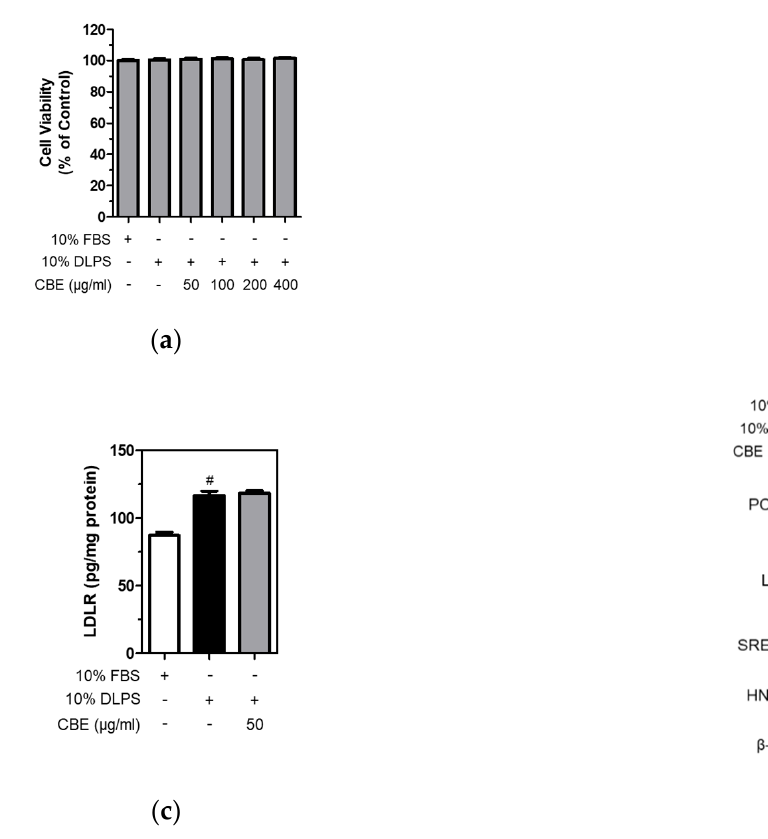
Figure 1. Viability of HepG2 cells in the presence of CBE (50, 100, 200, 400 µg/mL) under lipid depletion conditions ( a ). Intracellular PCSK9 ( b ) and LDLR ( c ) levels were measured using ELISA. PCSK9 and LDLR, and the transcription factor SREBP2 and HNF-1 α protein expression ( d ) were measured using Western blot analysis in HepG2 cells treated with FBS, DLPS, or DLPS+CBE (50 µg/mL). #; significant difference between cells treated with FBS and DLPS (Student’s t -test, # p < 0.05; ### p < 0.001). *; significant difference between cells treated with DLPS and CBE (Student’s t -test, ** p < 0.01).